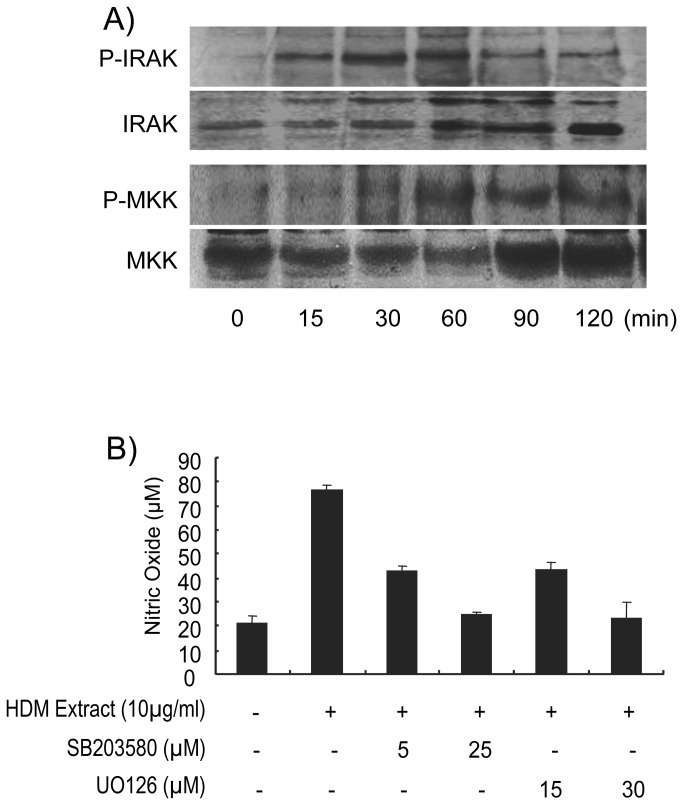
HDM extract-induced NO production involves the TLR2- and TLR4- associated MyD88 signaling pathways and is blocked by p38MAPK and MEK-1, -2 inhibitors.(A) Analysis of phosphorylation of IRAK-1 and MKK. Cellular extracts from HDM extract-stimulated MH-S cells (6x106 cells/mL) were evaluated for p-IRAK-1 and p-MKK protein expression by western blot. (B) Cells were pre-treated with increasing doses of U0126 and SB203580, a MEK-1/2 and a p38MAP kinase inhibitor respectively, for 4 h, and then stimulated with HDM extract for 24 hours. Accumulation of NO in supernatants was evaluated with the Griss Reagent. All samples were analyzed in triplicate. Each bar represents the mean ± SEM of nitrite levels in three replicate wells.